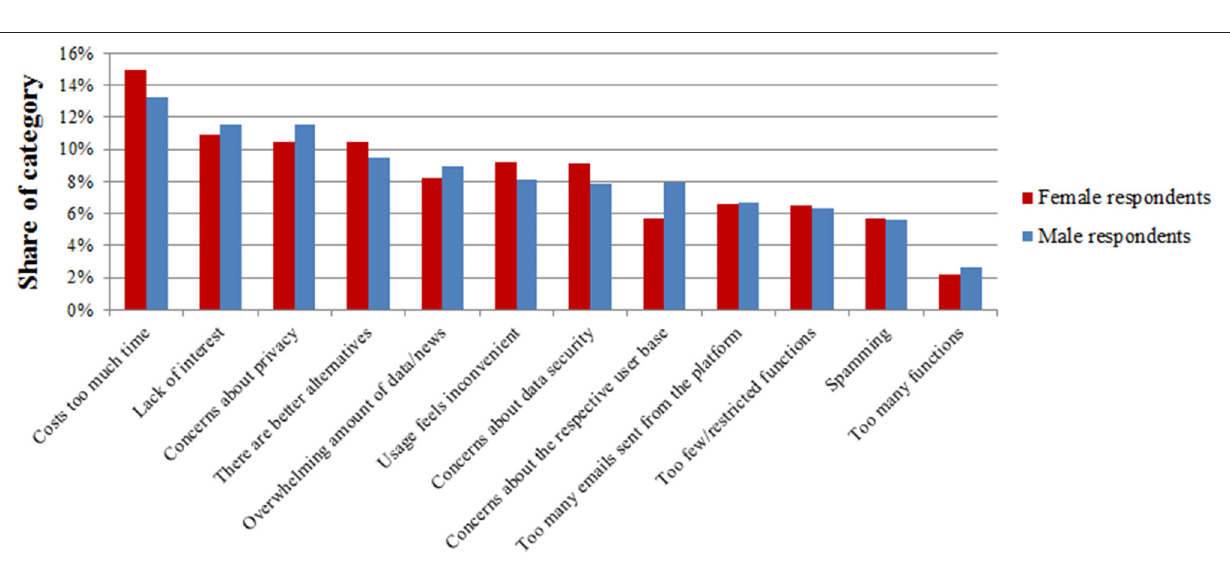
FIGURE 2 | Concerns regarding social media usage for work purposes (non-service-specific) by